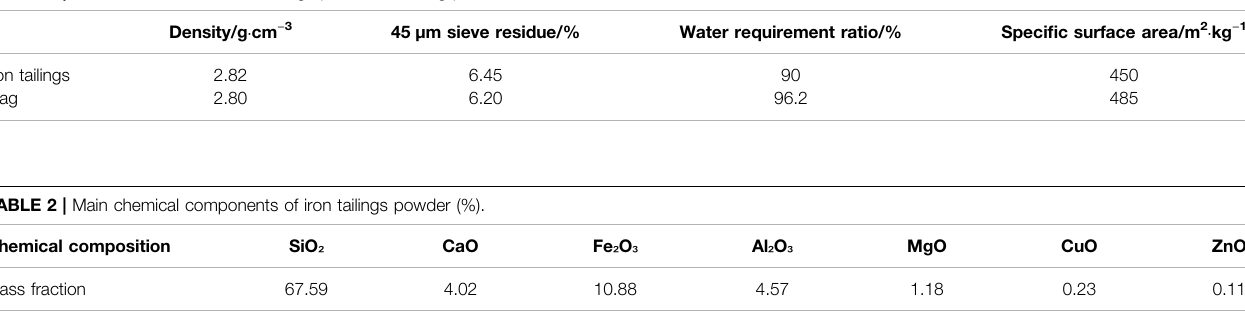
TABLE 1 | Technical indexes of iron tailings powder and slag powder.